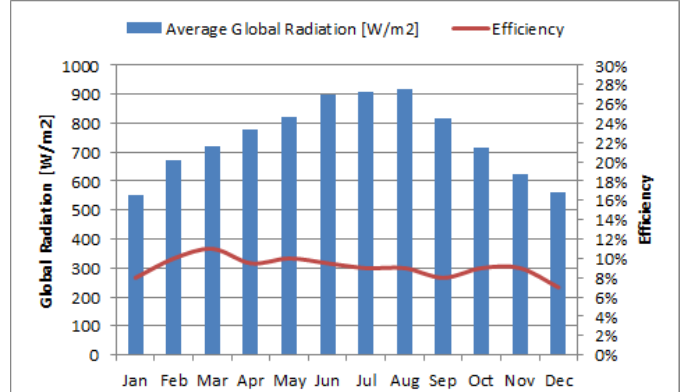
Figure 4. Average Global Radiation and Efficiency in year 2015